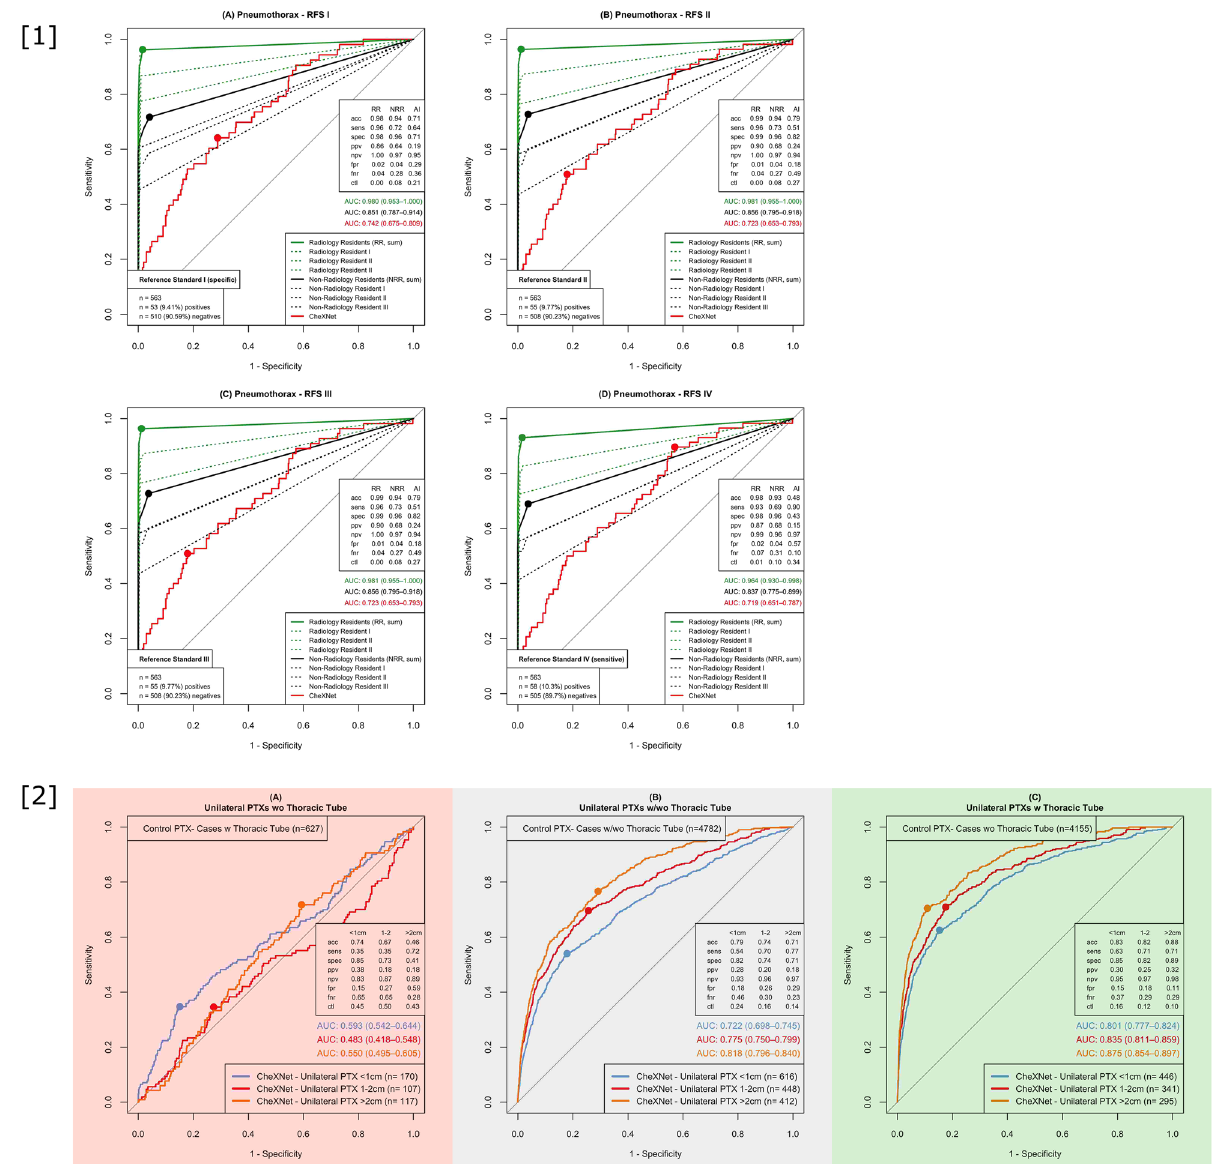
Figure 2. Benchmarking of pneumothorax detection; [ 1 ] shows the results of the CXR EU cohort for all reference standards (RFS I–IV, ( A )–( D )) pooled in subgroups of Radiology Residents (RR), Non-Radiology Residents (NRR) and CheXNet classifier “Pneumothorax” – CheXNet classifier “Pneumothorax” was statistically significant outperformed by RR consensus (green curve) and performed worse than NRR consensus (black curve) in all four RFS. Dotted green and black lines show individual reader’s performance levels. Accuracy (acc), sensitivity (sens), specificity (spec), positive predictive value (ppv), negative predictive value (npv), false positive rate (fpr), false negative rate (fnr), close top left (ctl) and area under the curve (AUC; with 95%-confidence intervals) are given for all consensus and CheXNet AI ROCs; [ 2 ] shows benchmarking results of the SCXR PTX cohort pooled by unilateral PTX size. ( A ) Considering PTX positive cases without inserted thoracic tubes CheXNet performed poorly in all subgroups. ( B / C ) Performance increases notably if the proportion of cases with inserted thoracic tube increases ( B ) or if PTX positive cases with inserted thoracic tubes are considered exclusively ( C